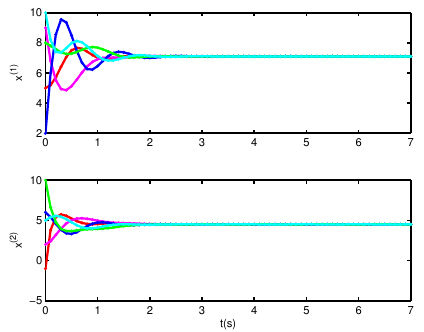
Figure 3. States of followers with general topology. Symmetric Topology. The symmetric follower topology satisfying Assumptions 1 and 3 is shown in Figure